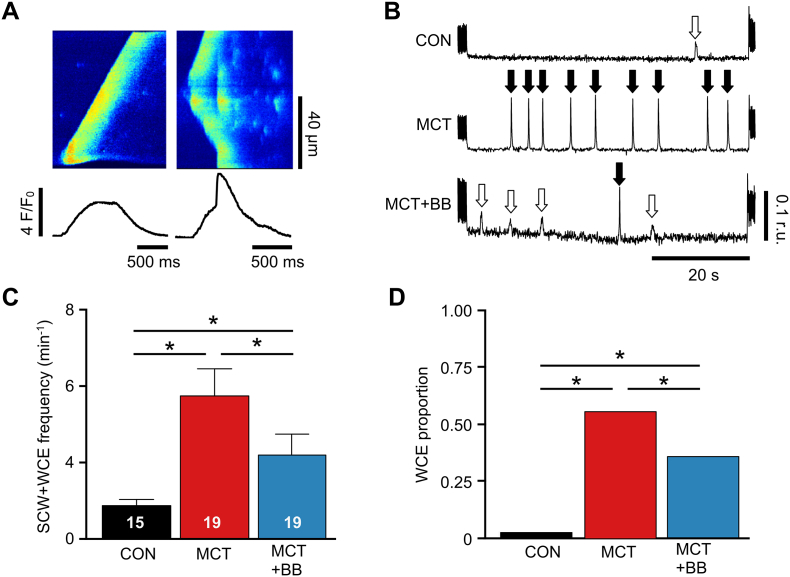
Frequency of spontaneous Ca2+ release was decreased by BB. A Contrasting morphologies of spontaneous Ca2+ waves (SCWs) and whole cell events (WCEs) in linescan (upper traces) and spatially averaged traces (lower traces) from unstimulated MCT RV myocytes. B Ca2+ release events during a 1 min quiescent period showing SCWs (open arrows) and WCEs (filled arrows). C. BB attenuated the total (SCW + WCE) number of Ca2+ releases, myocyte numbers given in the fig. D BB attenuated the proportion of WCEs. N = 5–6 rats per group. C one-way ANOVA, D Fisher's Exact test. *P < .05.